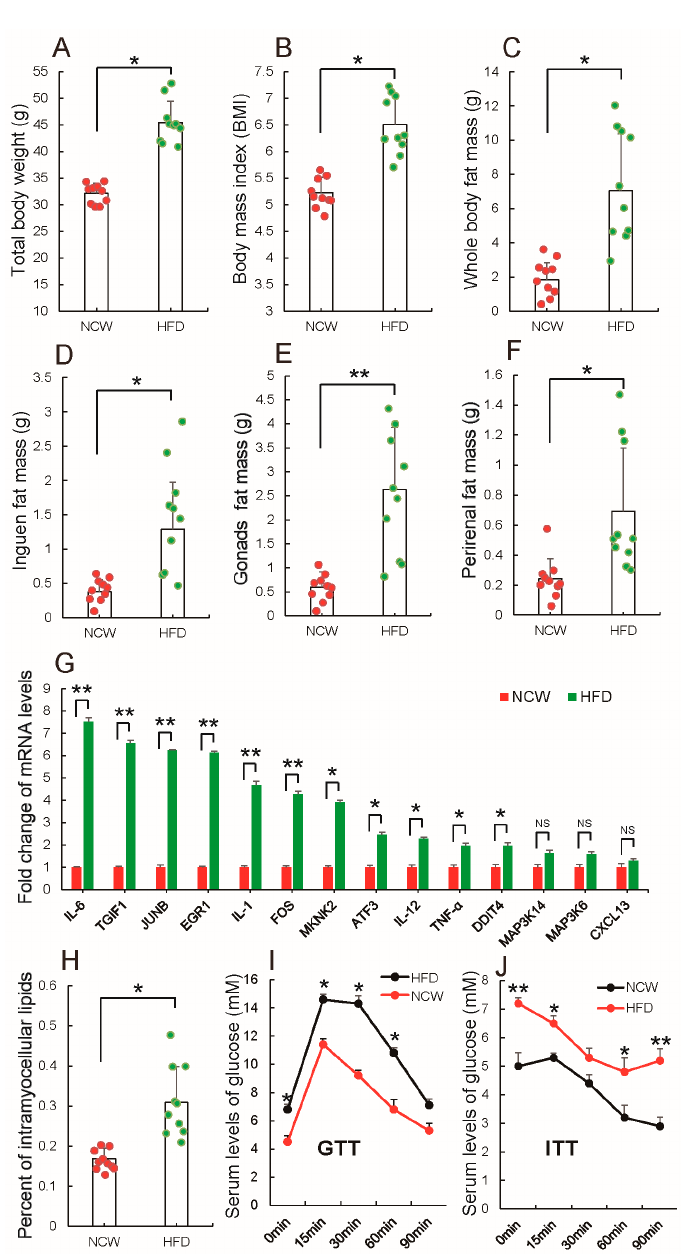
Figure 1. High-fat diet (HFD) feeding induces obesity. Following 13 weeks of normal chow (NCW)- or HFD-feeding in Kunming mice, ( A ) body weight; ( B ) body mass index (BMI); ( C ) whole body fat mass; ( D ) inguen fat mass; ( E ) gonads fat mass; ( F ) perirenal fat mass; and ( G ) the mRNA levels of inflammatory stress-related genes in adipose tissues were measured. Moreover, ( H ) the authors quantified intramyocellular lipids located in the same leg muscle tissues; performed ( I ) glucose-tolerance test (GTT) and ( J ) insulin-tolerance test (ITT). All results are presented as means ± standard error (SE). n = 10. * p < 0.05; ** p < 0.01; NS, no significance.